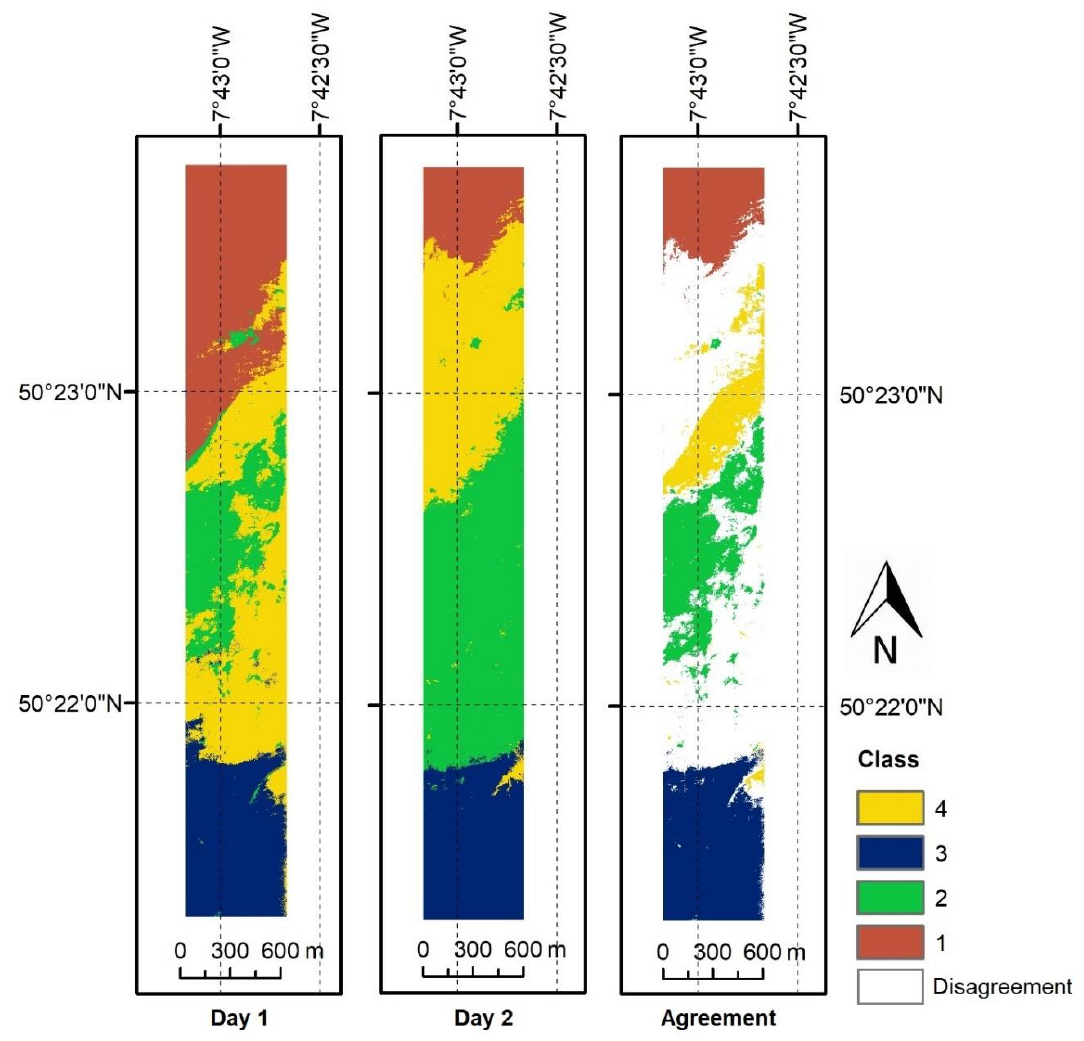
Figure 8. 2015 resulting habitat maps using k-means clustering algorithm. Left, 2015 Day 1 map. Middle, 2015 Day 2 map. Right, agreement between maps. Mercator projection with standard parallel 50. WGS84 datum.